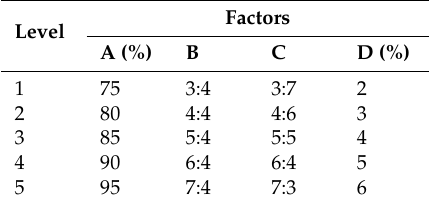
Table 1. Orthogonal test design level.